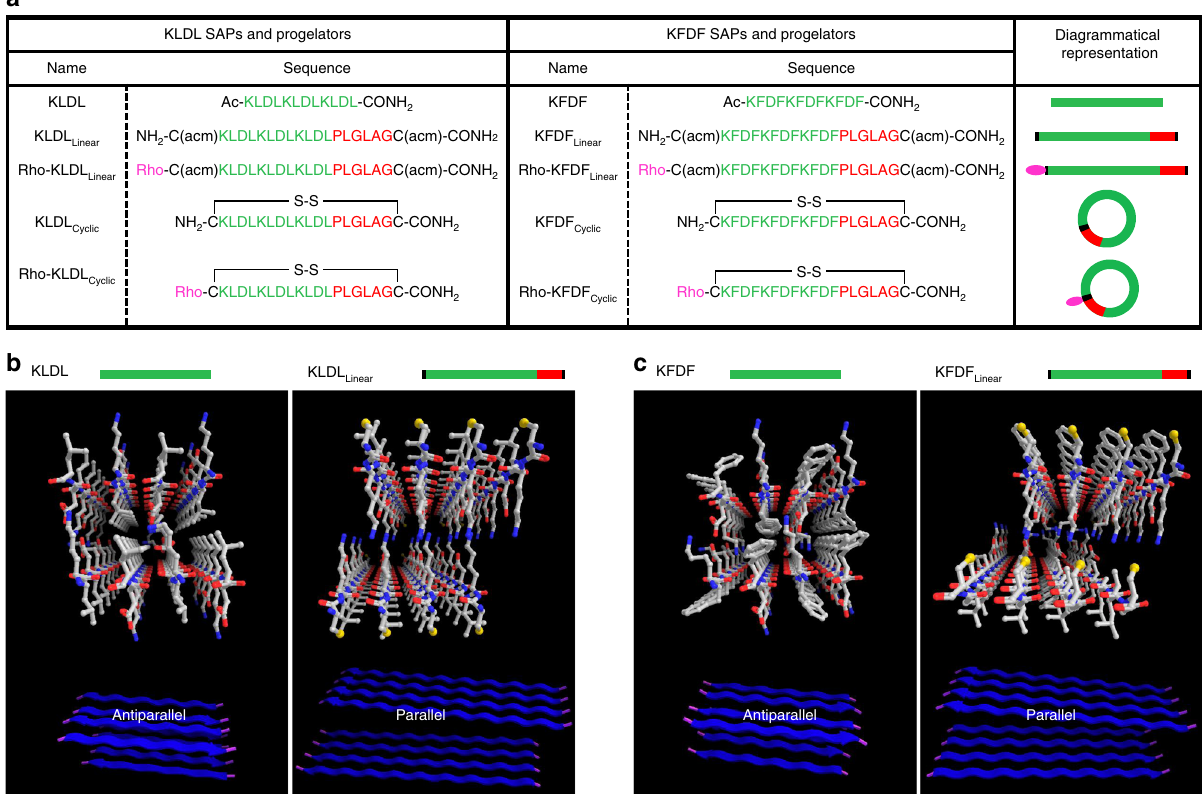
Fig. 2 Sequences and design of self-assembling peptides (SAPs) and cyclic, enzyme-responsive progelators. a Table of SAPs and progelators based on the (KLDL) 3 and (KFDF) 3 amino acid gelling sequence with corresponding diagrammatical representations (green is progelator sequence, red is recognition sequence, pink is fl uorophore). Sequences are shown for the base, unmodi fi ed SAPs (KLDL and KFDF) and modi fi ed SAPs (KLDL Linear and KFDF Linear ) primed for cyclization but lacking fl uorescent labels, together with the corresponding cyclized versions (progelators, KLDL Cyclic and KFDF Cyclic ). In addition, rhodamine-labeled modi fi ed SAPs (Rho-KLDL Linear and Rho-KFDF Linear ) are shown, together with their corresponding labeled cyclized progelators (Rho- KLDL Cyclic and Rho-KFDF Cyclic ). The ‘ acm' denotes the acetamidomethyl protecting group on Cysteine residues. ‘ Rho' designates the 5(6)- carboxytetramethyl rhodamine label. b , c Modeling predicts β -sheet re-orientation, rather than self-assembly disruption, following signi fi cant SAP functionalization. b Predicted structures and ribbon diagrams (bottom) of KLDL and KLDL Linear SAPs from FibPredictor simulations revealing antiparallel and parallel β -sheet orientations, respectively. c Predicted structures and ribbon diagrams (bottom) of KFDF and KFDF Linear SAPs from FibPredictor simulations revealing antiparallel and parallel β -sheet orientations, respectively (see Supplementary Tables 1-2). Ball and stick models of interacting peptides are displayed with carbon, oxygen, and nitrogen atoms in white, red, and blue,